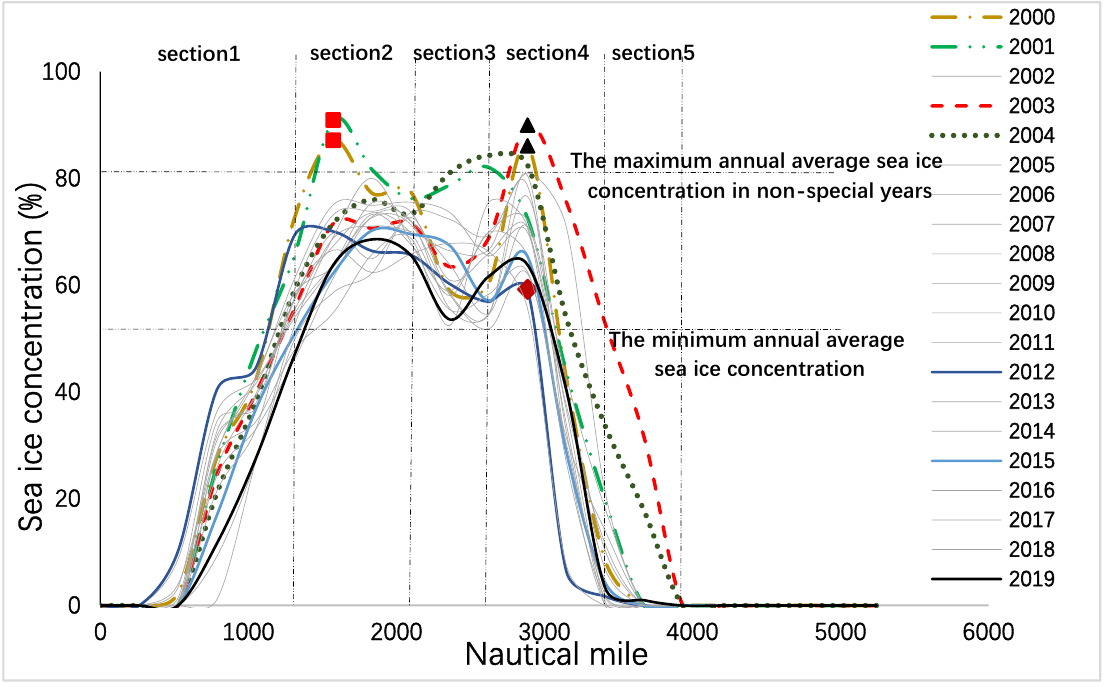
Figure 2. Average annual sea ice concentration of the NEP from 2000 to 2019. Among them, the red squares indicate that at 1574 nautical miles, the sea ice concentration in 2001 and 2000 were the top two places, respectively. The black triangles indicate that at 2885 nautical miles, the sea ice concentration in 2003 and 2000 were the top two places, respectively. The red diamond indicates that at 2885 nautical miles, the sea ice concentration in 2012 was the lowest.